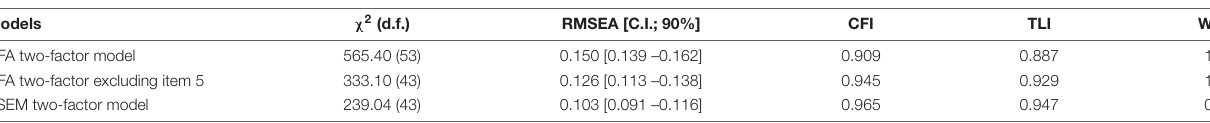
TABLE 1 | Fit index values for the tested models.